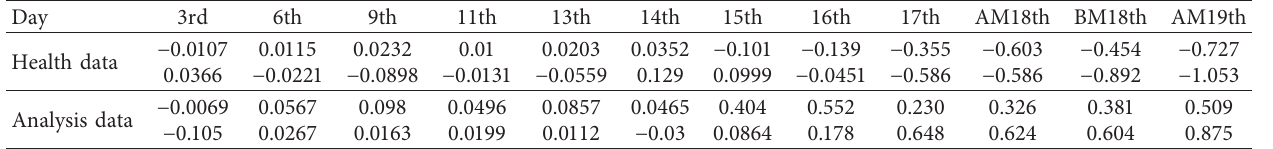
Table 3: Centroid of the two clusters.